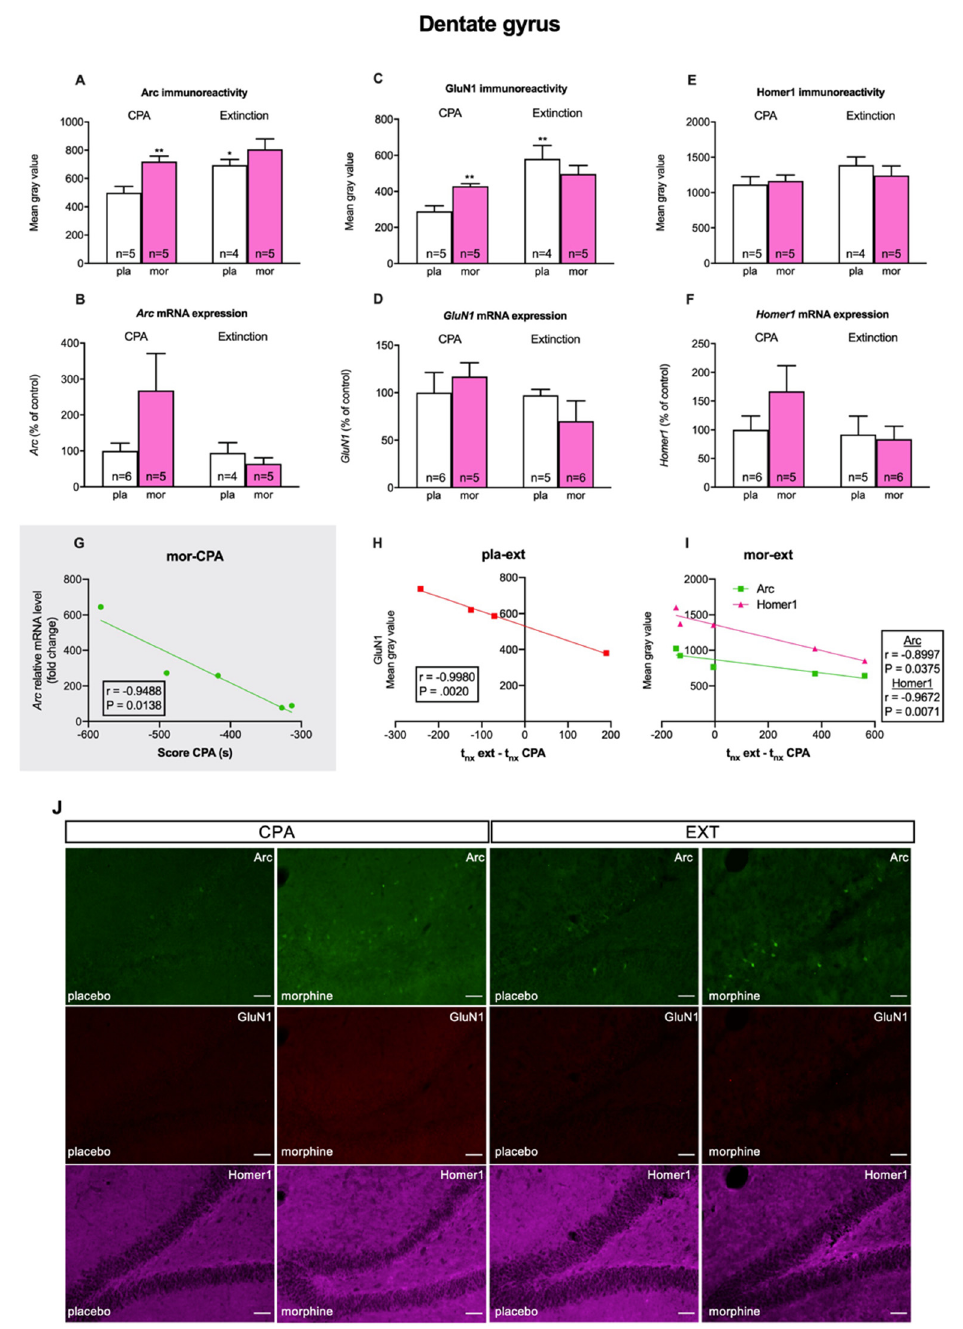
Figure 5. Dentate gyrus: ( A , B ) Analysis of Arc immunoreactivity and mRNA expression during CPA and extinction test. ( C , D ). Analysis of GluN1 immunoreactivity and mRNA expression during CPA and extinction test. ( E , F ). Analysis of Homer1 immunoreactivity and mRNA expression during CPA and extinction test. ( G ) Correlation between relative mRNA levels of Arc and the CPA score in morphine dependent rats. ( H ) Correlation between GluN1 immunoreactivity and the difference between the time spent in the naloxone chamber during extinction test and CPA test in placebo rats that underwent extinction protocol. ( I ) Correlation between Homer1 immunoreactivity and the difference between the time spent in the naloxone chamber during extinction test and CPA test in morphine-treated rats that underwent extinction protocol and between Arc immunoreactivity and same time parameter. ( J ) Representative epifluorescence images showing triple immunostaining of Arc (green), GluN1 (red) and Homer1 (pink) during CPA and extinction test. * p < 0.05, ** p < 0.01 vs. P-CPA. Each bar corresponds to mean ±